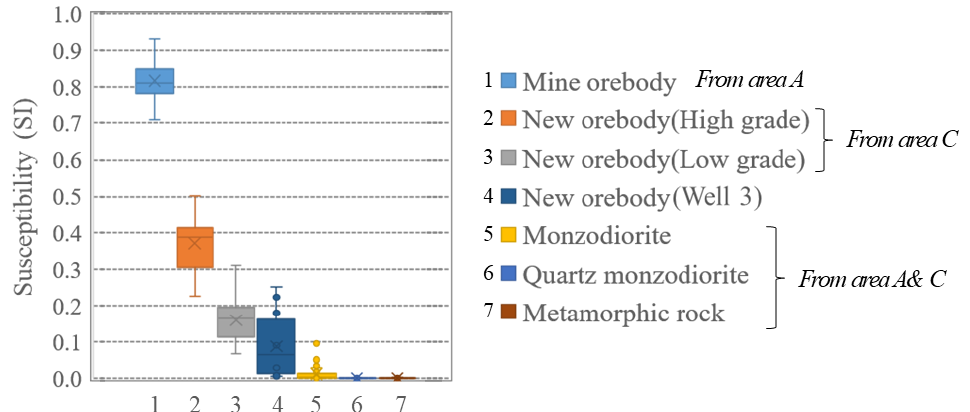
Figure 9. Box plots of measured susceptibility according to rock type from drilling data. The solid lines in the box plots represent the median value of each rock type.